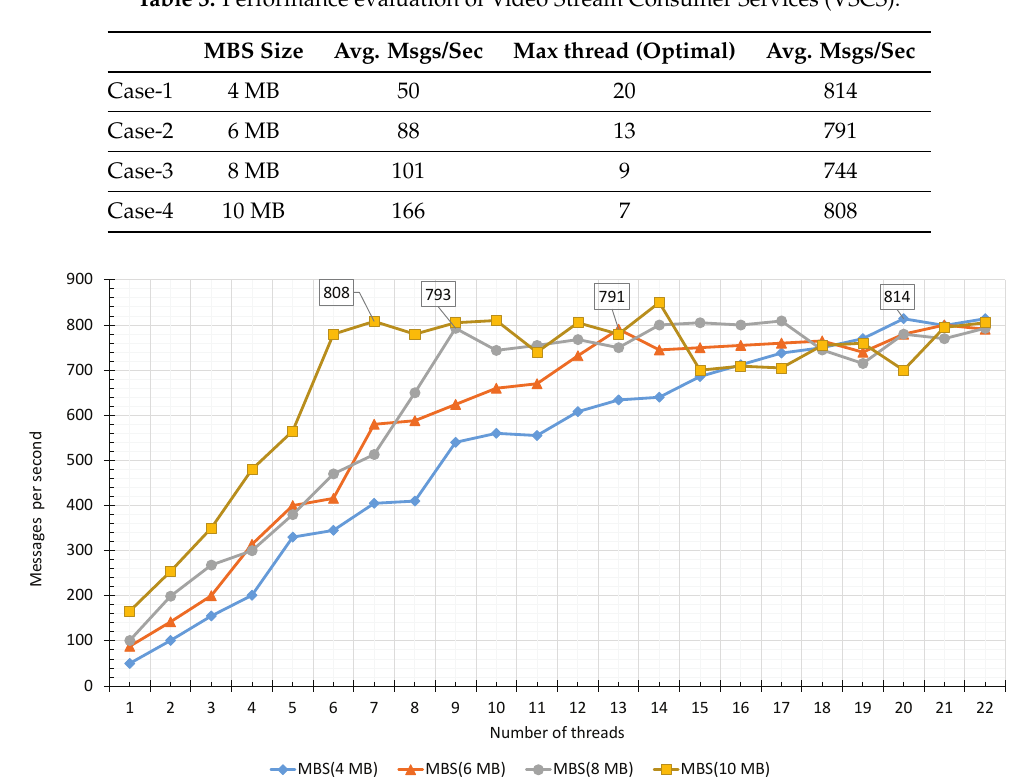
Table 3. Performance evaluation of Video Stream Consumer Services (VSCS).